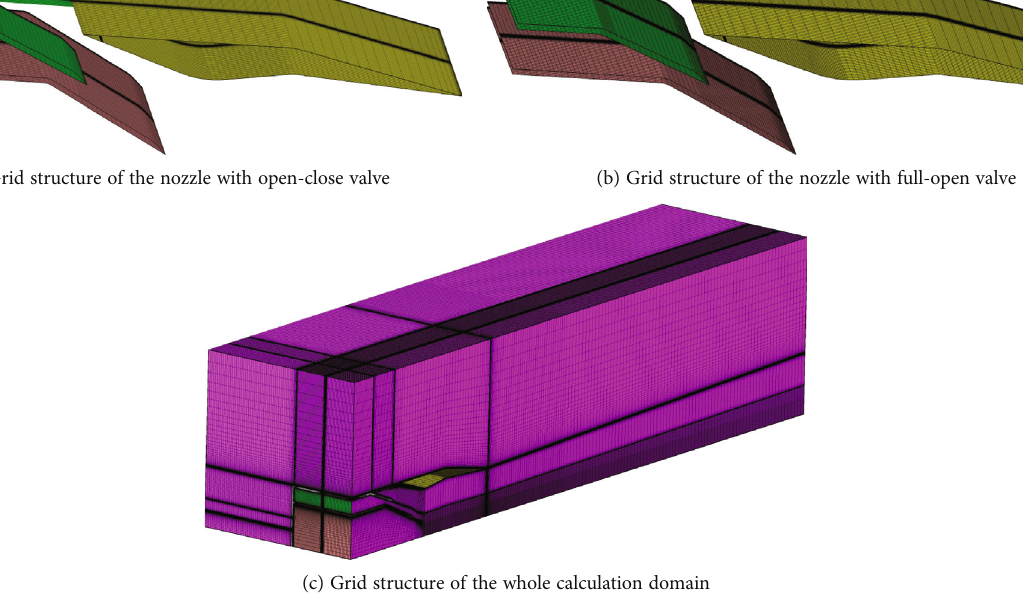
Figure 3: Grid structure of the ejector nozzle model.